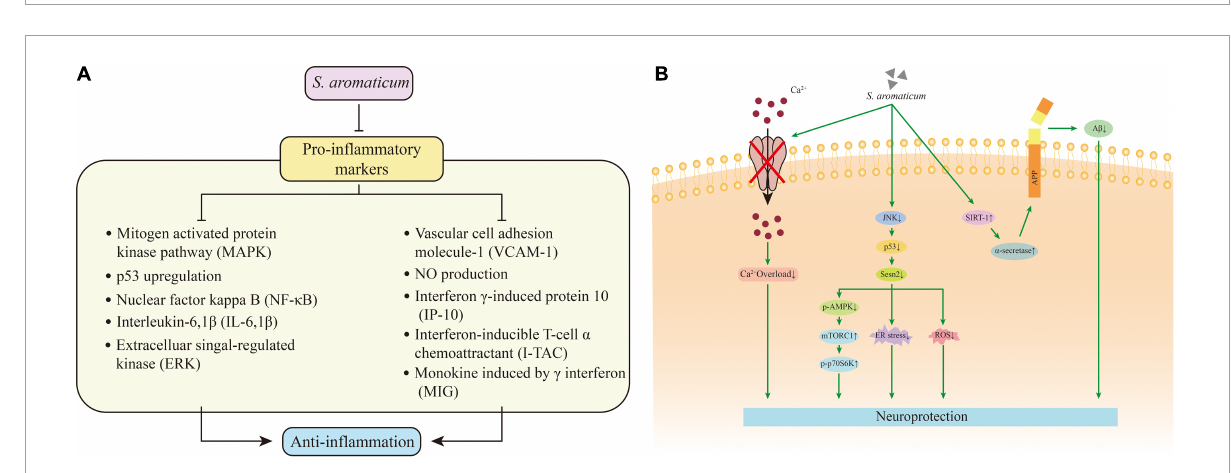
restoring oxidative status, inhibiting microglia signaling